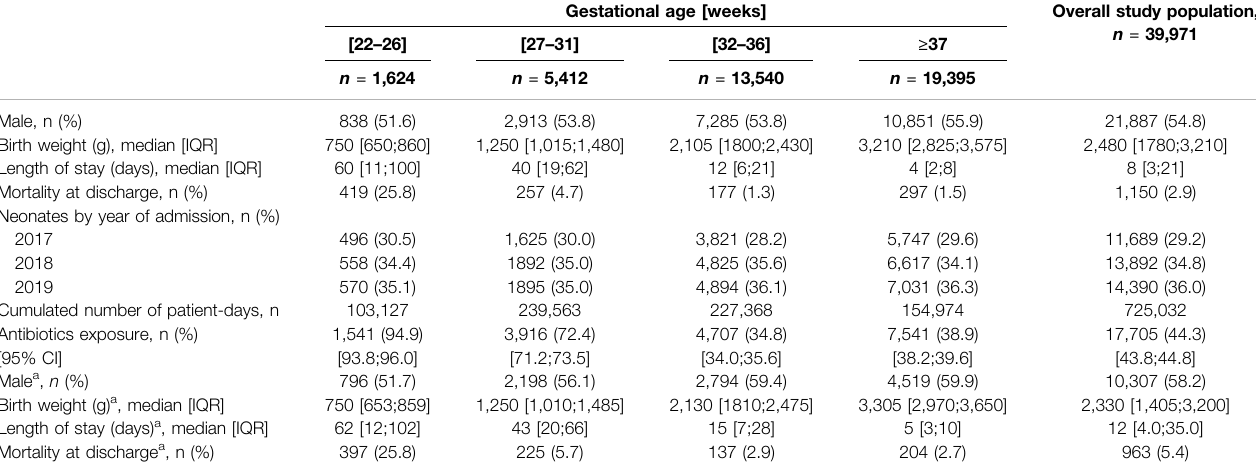
TABLE 1 | Population characteristics and antibiotic